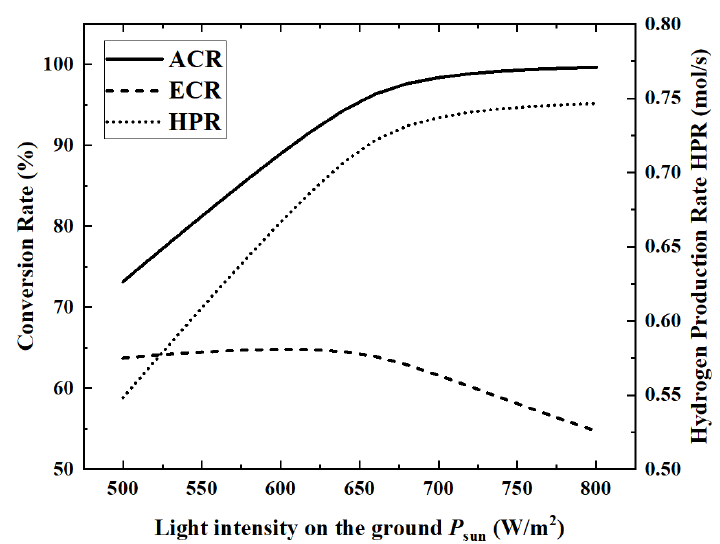
Figure 5. Effect of light intensity on ACR, ECR and HPR.